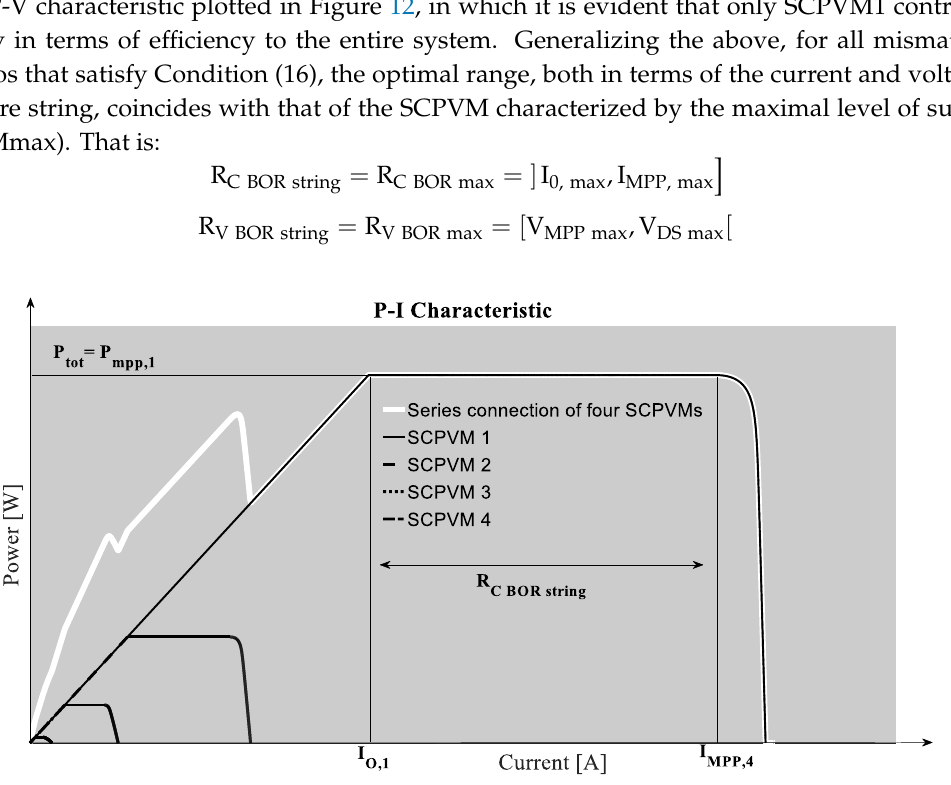
Figure 11. P-I characteristic of the series connection of four SCPVMs.